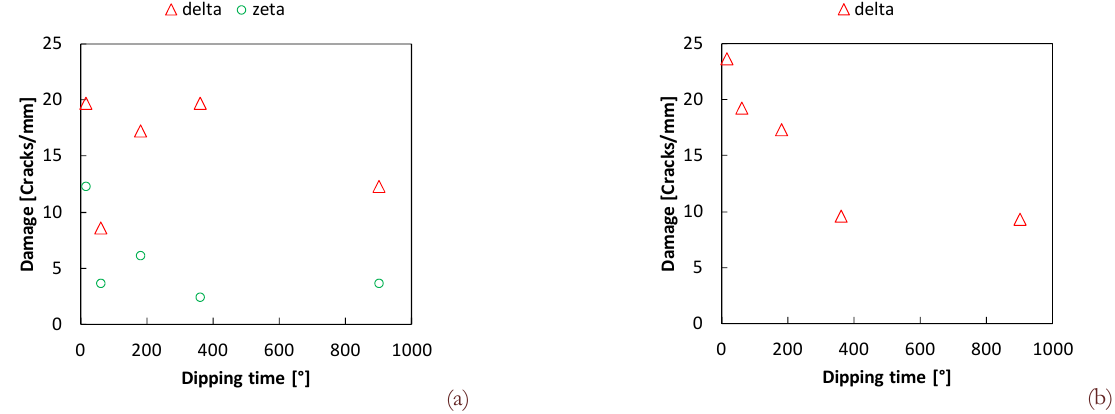
Figure 7: Intermetallic phases radial damage: a) in Zn-Sn coatings, b) in Zn-Ti